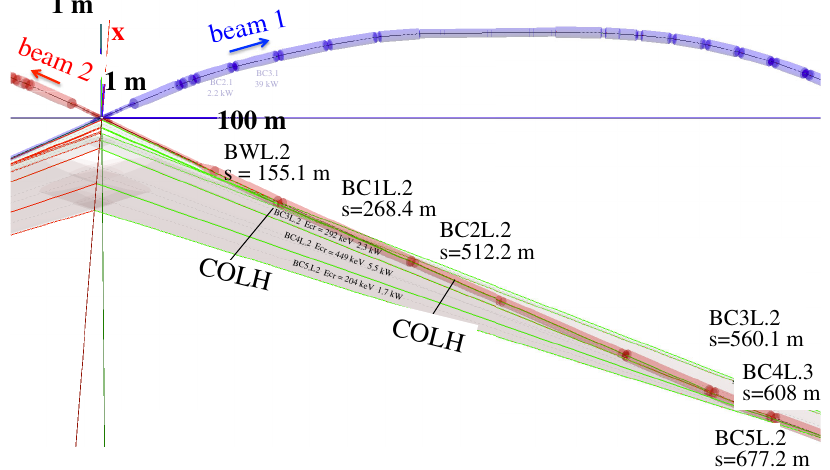
FIG. 5. SR from bending magnets at about 600 m upstream the IR.